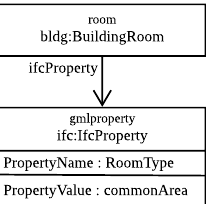
Figure 5. A rule converting a direct attribute to a new node, here the name attribute of IfcSpace in IFC to a generic IfcProperty node named RoomNumber in CityGML.